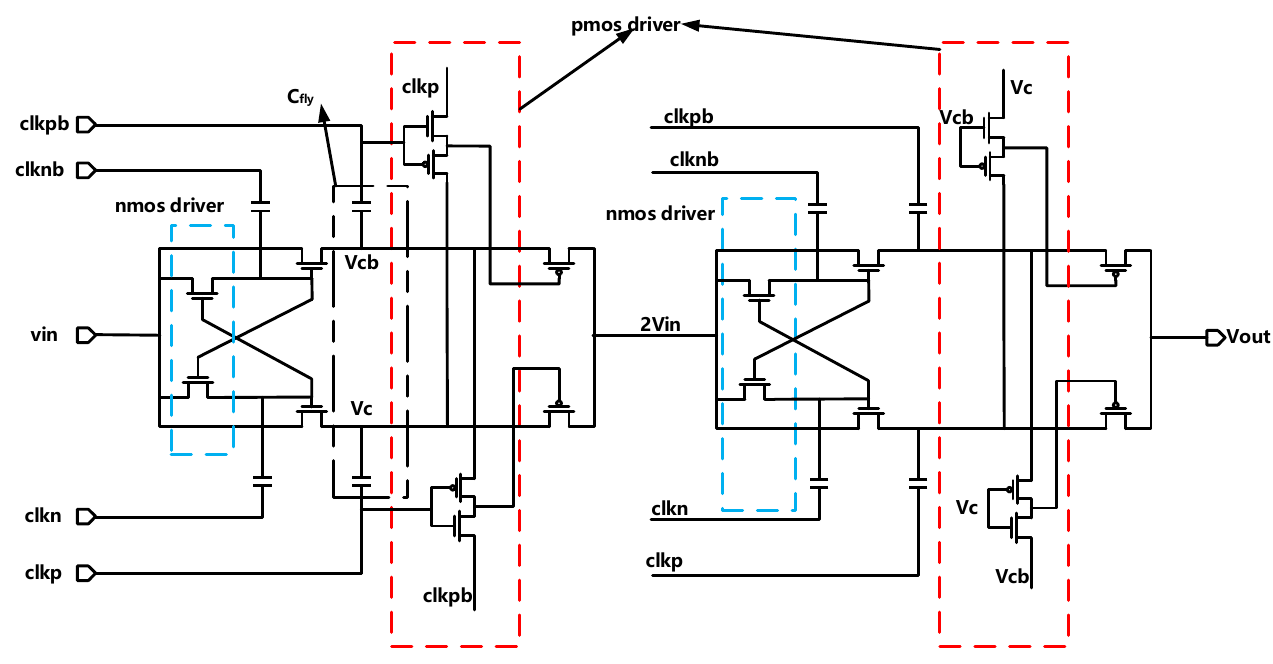
Figure 7. Schematic of the four-phase charge pump.